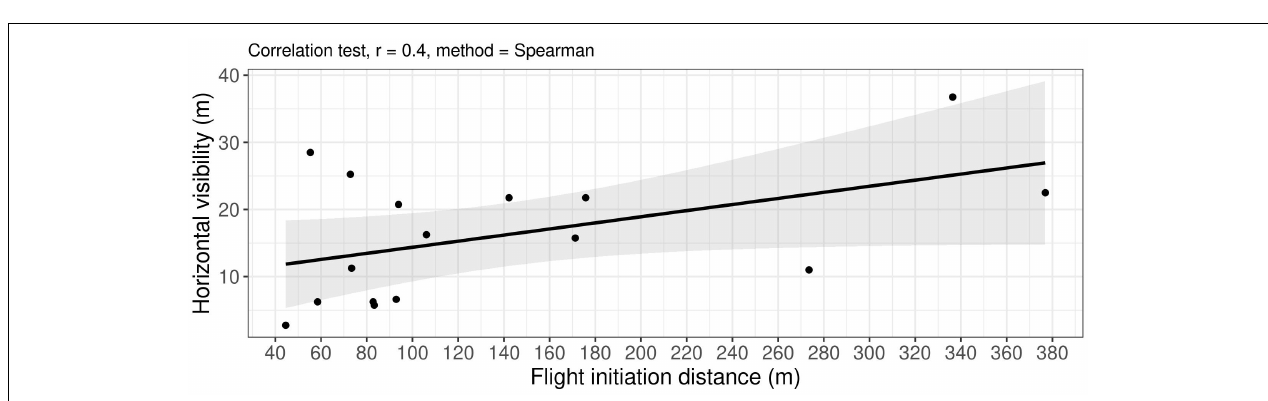
FIGURE 3 | The relation between flight initiation distances ( N = 16) and the horizontal visibility (both in meters). Using the non-parametric Spearman’s rank-order correlation test based on experimental approach trials by humans on wolves in south-central Scandinavia, 2018–2021. Wolves that did not fled are excluded ( N =